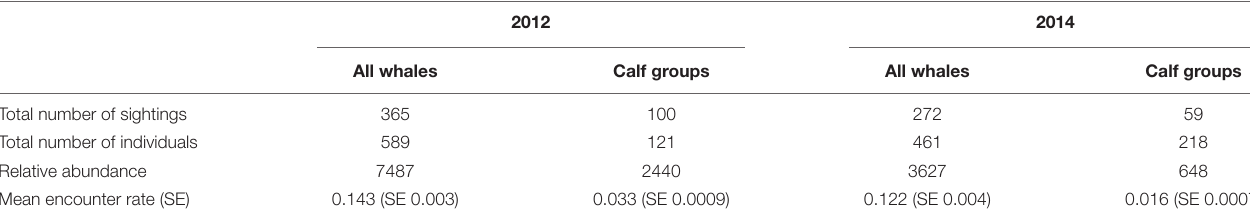
TABLE 1 | The number of sightings, relative abundance and mean encounter rates for groups of all whales and groups containing a calf during the 2012 and 2014 aerial